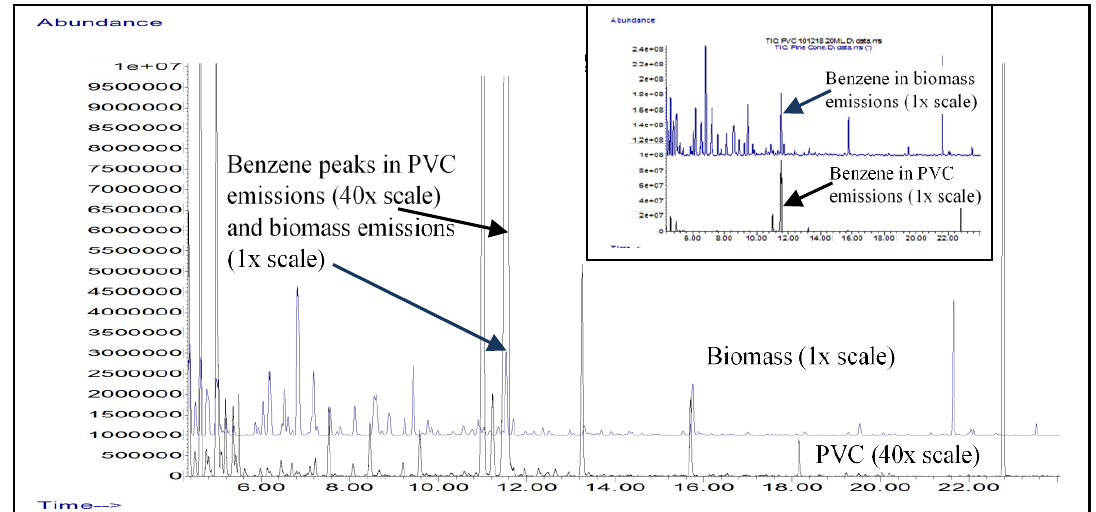
Figure 1. Overlaid GC-MS chromatograms of emissions from burning biomass compared to burning PVC pipes. Note that the scale for PVC emissions is expanded forty-fold to show the presence of about 85 volatile organic compounds (VOCs) detected at trace levels. The inset figure shows the same chromatograms on a common scale and the presence of about six major components in the burning PVC emissions.